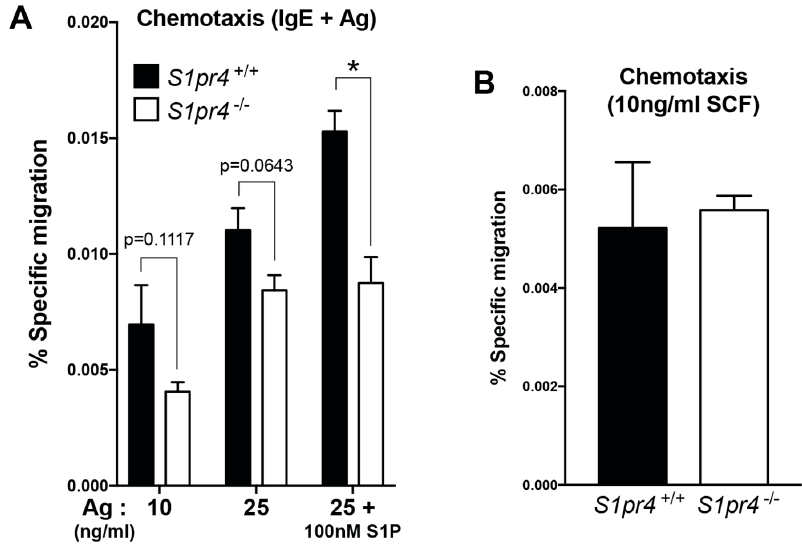
Figure 3. BMMC chemotaxis in the absence of S1pr4 expression. ( A ) BMMC from S1pr4 +/+ (solid bars) and S1pr4 − / − mice (open bars) grown in the presence of SCF and IL-3 for 6 weeks were sensitized with anti-DNP IgE in serum-free, cytokine-free media supplemented with 0.04% fatty acid-free bovine serum albumin (BSA) for 14 h. Sensitized cells were subject to transwell migration analysis using antigen (DNP; Ag) with or without 100 nM S1P as a chemoattractant at the indicated concentrations in the bottom chamber. ( B ) Chemotaxis of BMMC towards 10 ng/mL SCF in the bottom chamber. After 4 h incubation at 37 °C in 5% CO 2 , cells that migrated into the lower chamber were collected and counted. In each experiment, three to six technical replicates were performed for the S1pr4 +/+ and S1pr4 − / − cultures. Percent specific migration was calculated by taking the average number of cells in the bottom chamber/total input cells × 100. Data represents the mean ± SE normalized migration for three independent BMMC cultures for each genotype. In each experiment, migration of S1pr4 +/+ and S1pr4 − / − cultures were normalized to the average migration to Ag (10 ng/mL) across the 3 S1pr4 +/+ cultures. * p < 0.05.